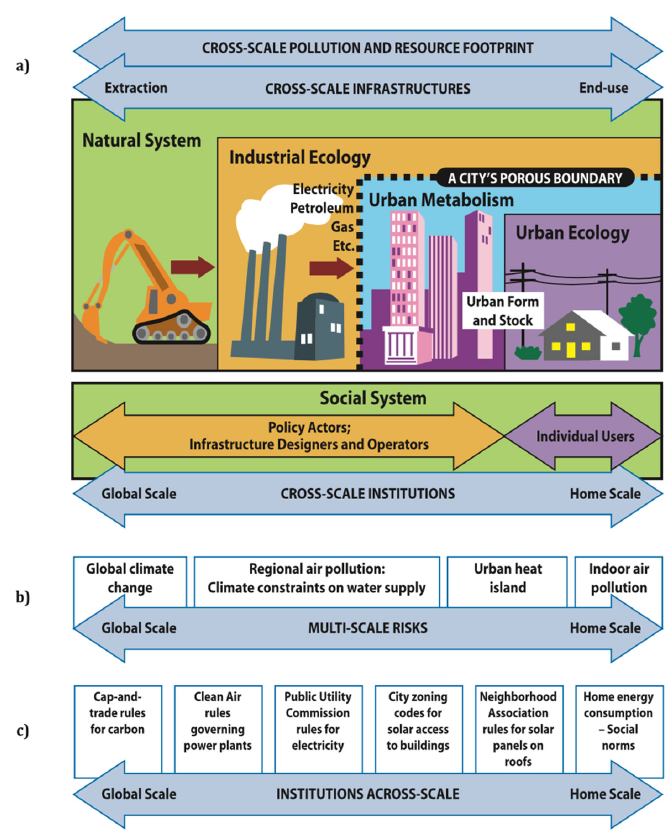
Figure 1. Social ‐ ecological ‐ infrastructural systems or SEIS [8]. It represents: the integration across the spatial scale ( a ); multi ‐ scale risks from infrastructure–environment interactions ( b ); examples of institutions that shape energy use and greenhouse gas (GHG) emissions ( c ).